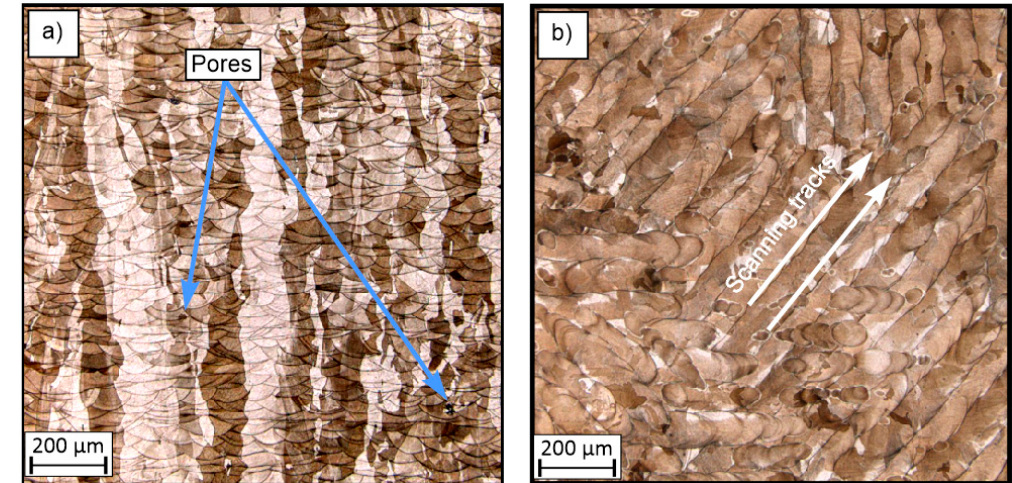
Figure 9. Microstructure of the surfaces of sample S_30: ( a ) perpendicular to the machine building platform, and ( b ) parallel to the machine building platform.